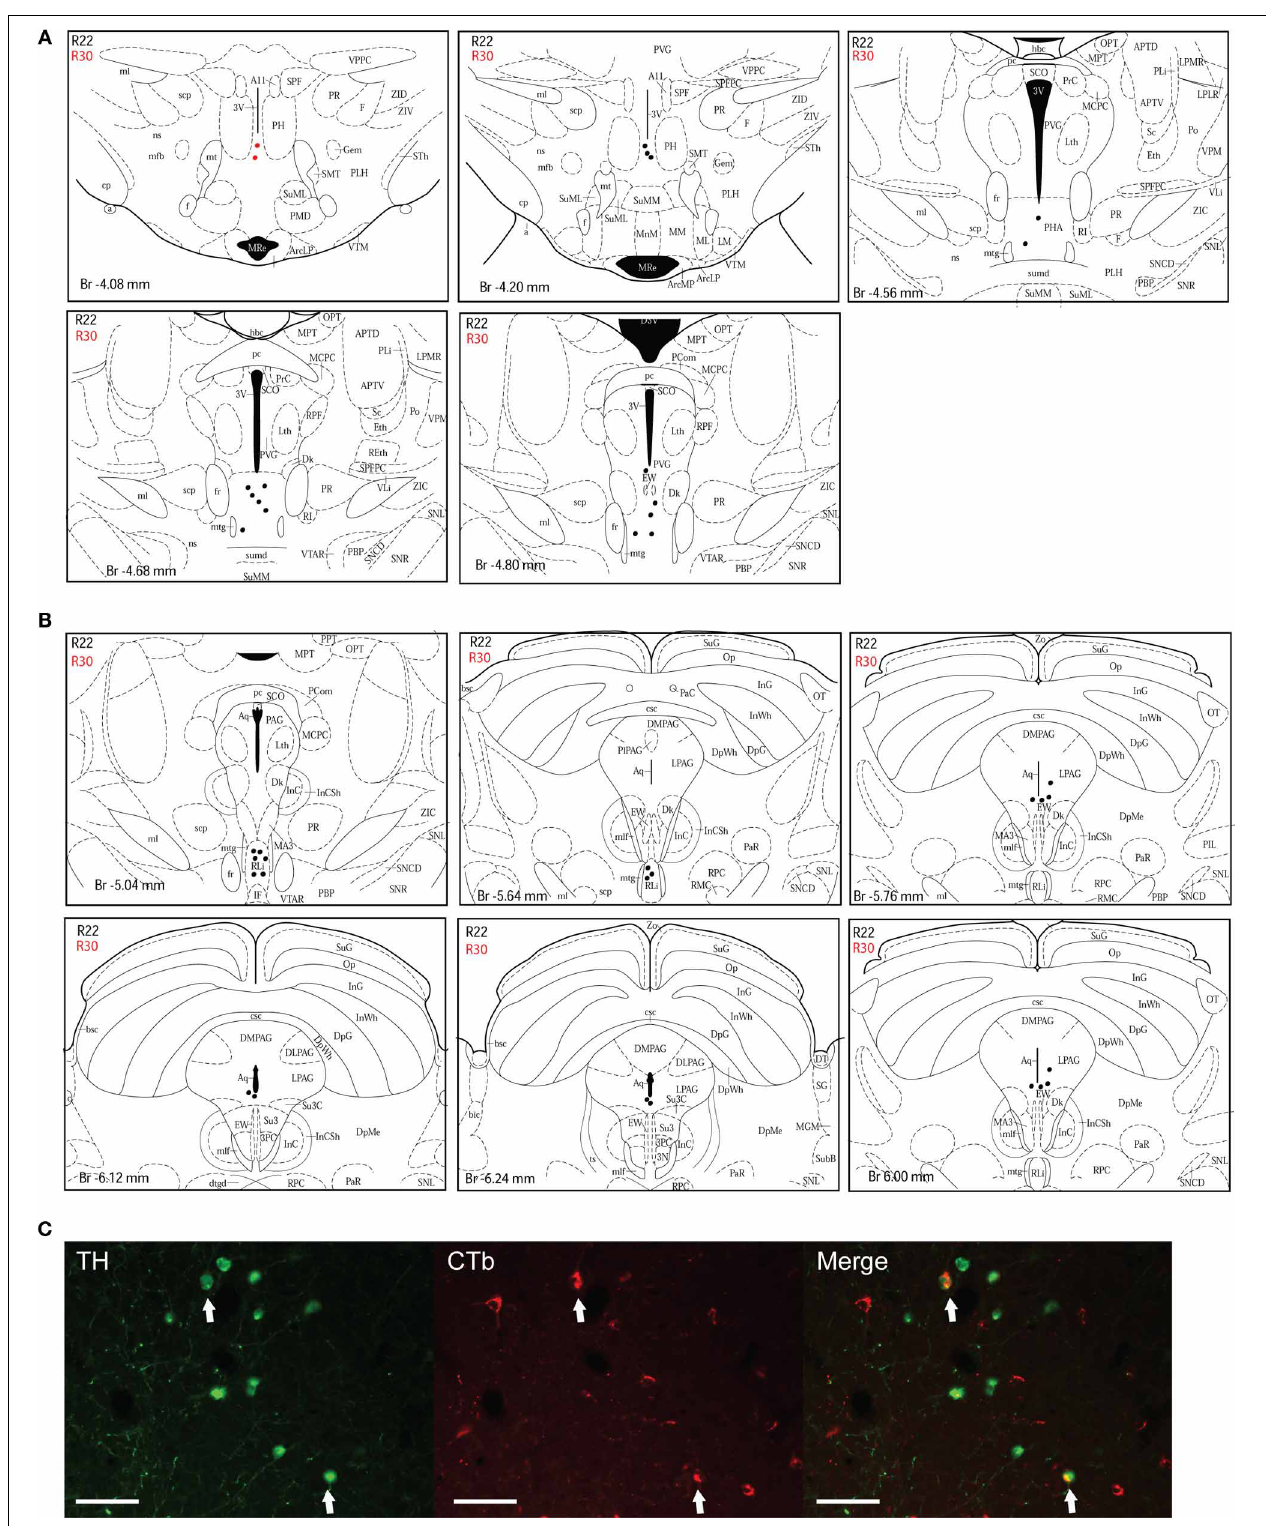
FIGURE 5 | Double-labeled neurons in the A10 dopaminergic cell group projecting to the dlPAG. (A) Distribution of CTb/TH-positive cells in the posterior hypothalamic area (PHA), case R22 (black dots) and R30 (red dots). Figures modified from Paxinos and Watson (1998). (B) Distribution of double-labeled neurons in the rostral linear nucleus of the raphe and the